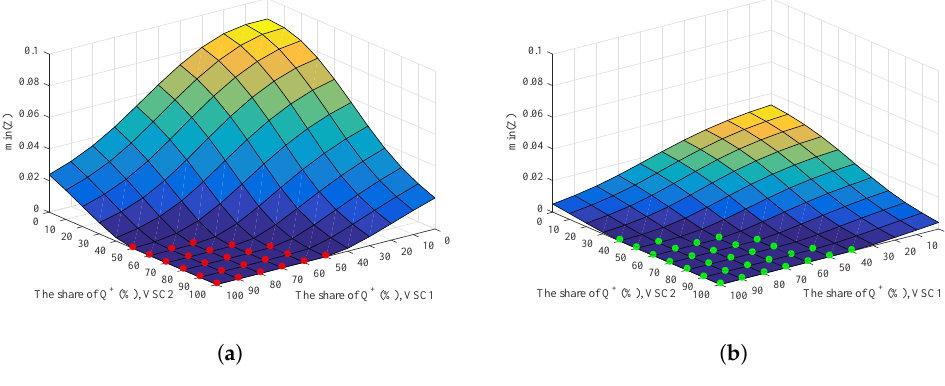
Figure 10. The values of min(Z) under different scenarios for an A–B fault at bus 4: ( a ) with profile 1 of Figure 9. ( b ) with profile 2 of Figure